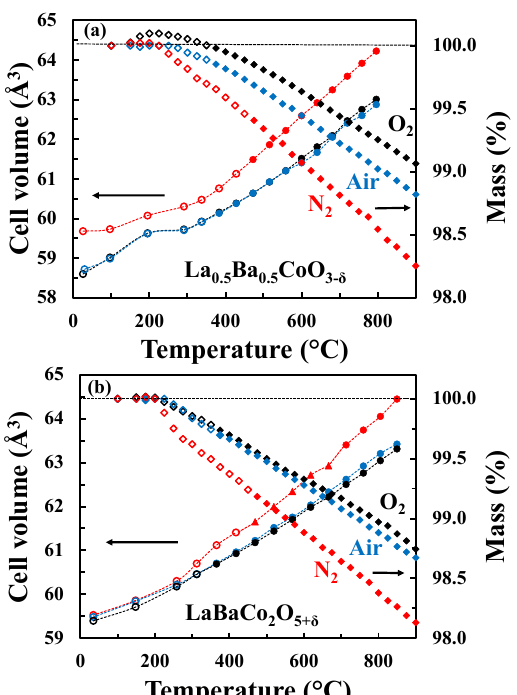
Figure 5. Unit cell volume (circles for tetragonal polymorph and triangles for orthorhombic polymorph) and relative mass change (diamonds) of ( a ) La 0.5 Ba 0.5 CoO 3 ‐δ and ( b ) LaBaCo 2 O 5+ δ as a function of temperature in O 2 (black symbols), air (blue symbols) and N 2 (red symbols). Open symbols represent data out of thermodynamic equilibrium. The dotted lines are guides to the eye.